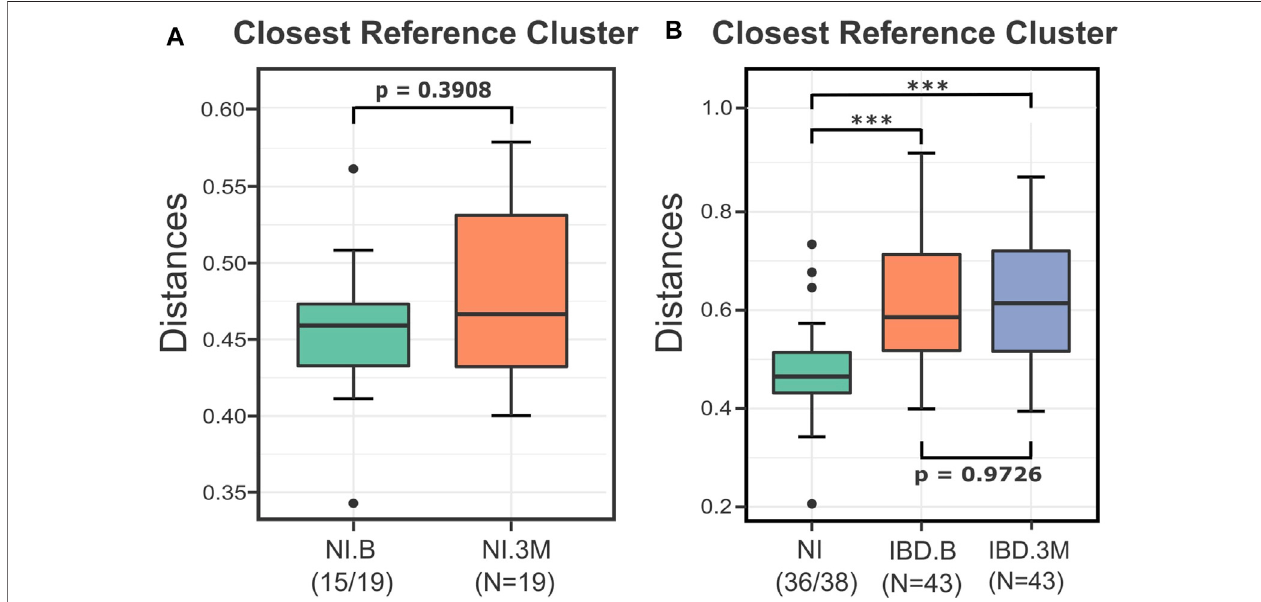
FIGURE 3 | Boxplots presenting the distances of the NI and IBD samples from their closest reference medoids before (B) and after (3M) the treatments. (A) The distances ofthe NI.3M samples from their closest medoid ofthe NI.B group implied that the iron replacement therapy (IRT) did not affectthe microbial composition ofNI samplesconsiderably.Thetwogroupswerenotsigni fi cantlydifferent( p =0.3908),sofortherestoftheDivComanalysis,thesamplesweremergedandusedasauni fi ed reference group. (B) Boxplots displaying the impact of the iron replacement therapy on the IBD samples. The IRT did not shift the IBD samples closer to the NI group. The distances of the IBD groups (B and 3M) from the reference group of the NI samples are signi fi cantly different compared to those of the NI group ( p < 0.001). However, the two groups are highly related to each other ( p = 0.97). p -values: * < 0.05; *** < 0.01.